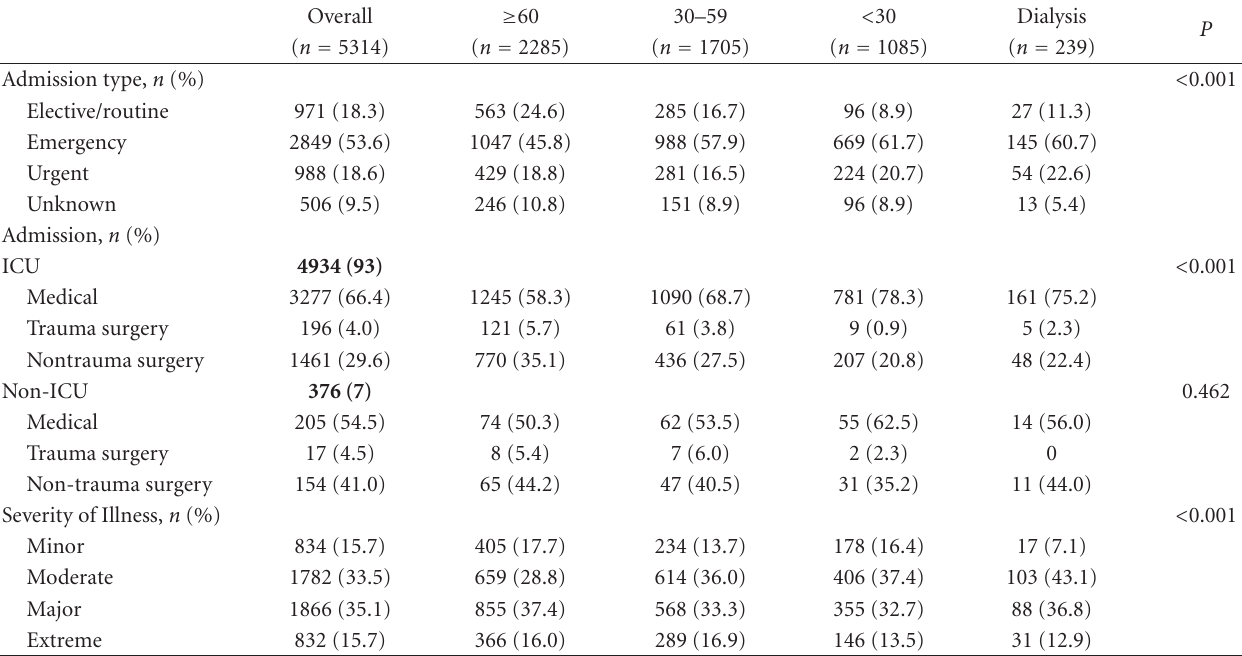
Table 3: Admission characteristics based on eGFR (mL/min/1.73m 2